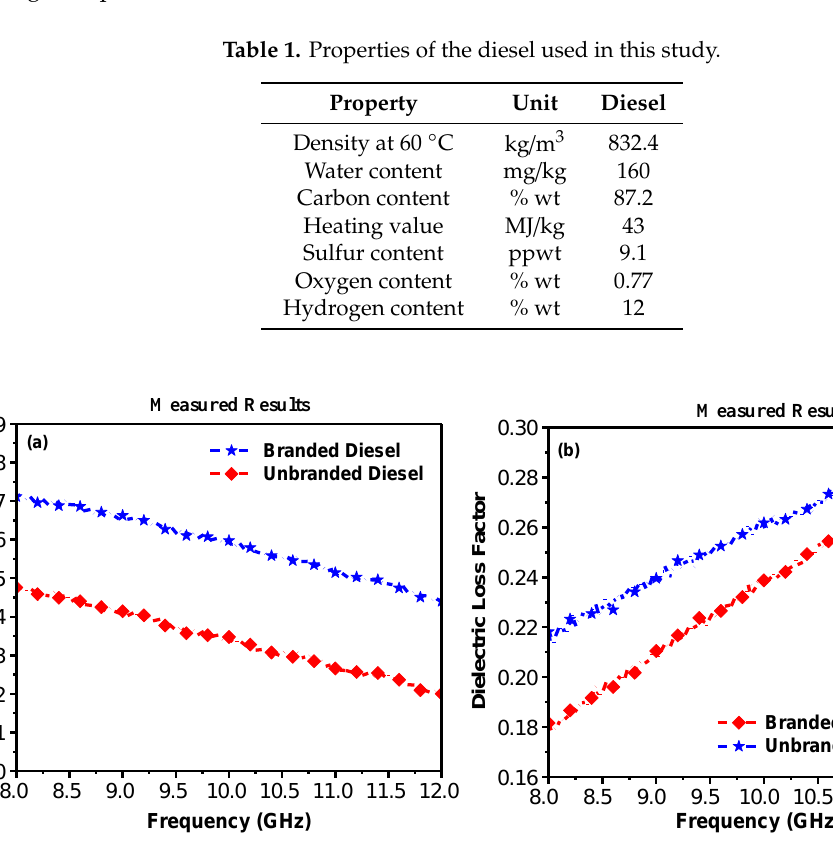
Figure 4. ( a ) Measured results of dielectric constant and ( b ) dielectric loss factor for branded and unbranded diesel. Table 2. Dielectric constant and loss tangent value for branded and unbranded diesel at different frequencies.